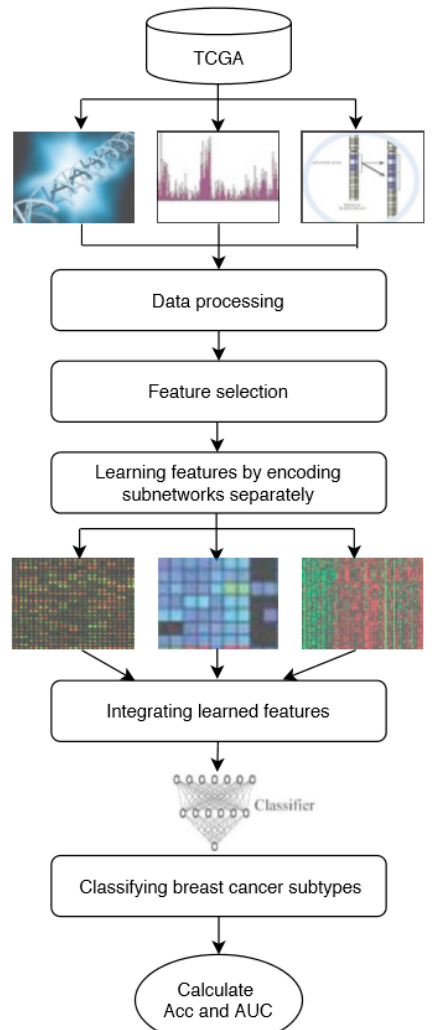
Figure 1. The workflow of DeepMO.